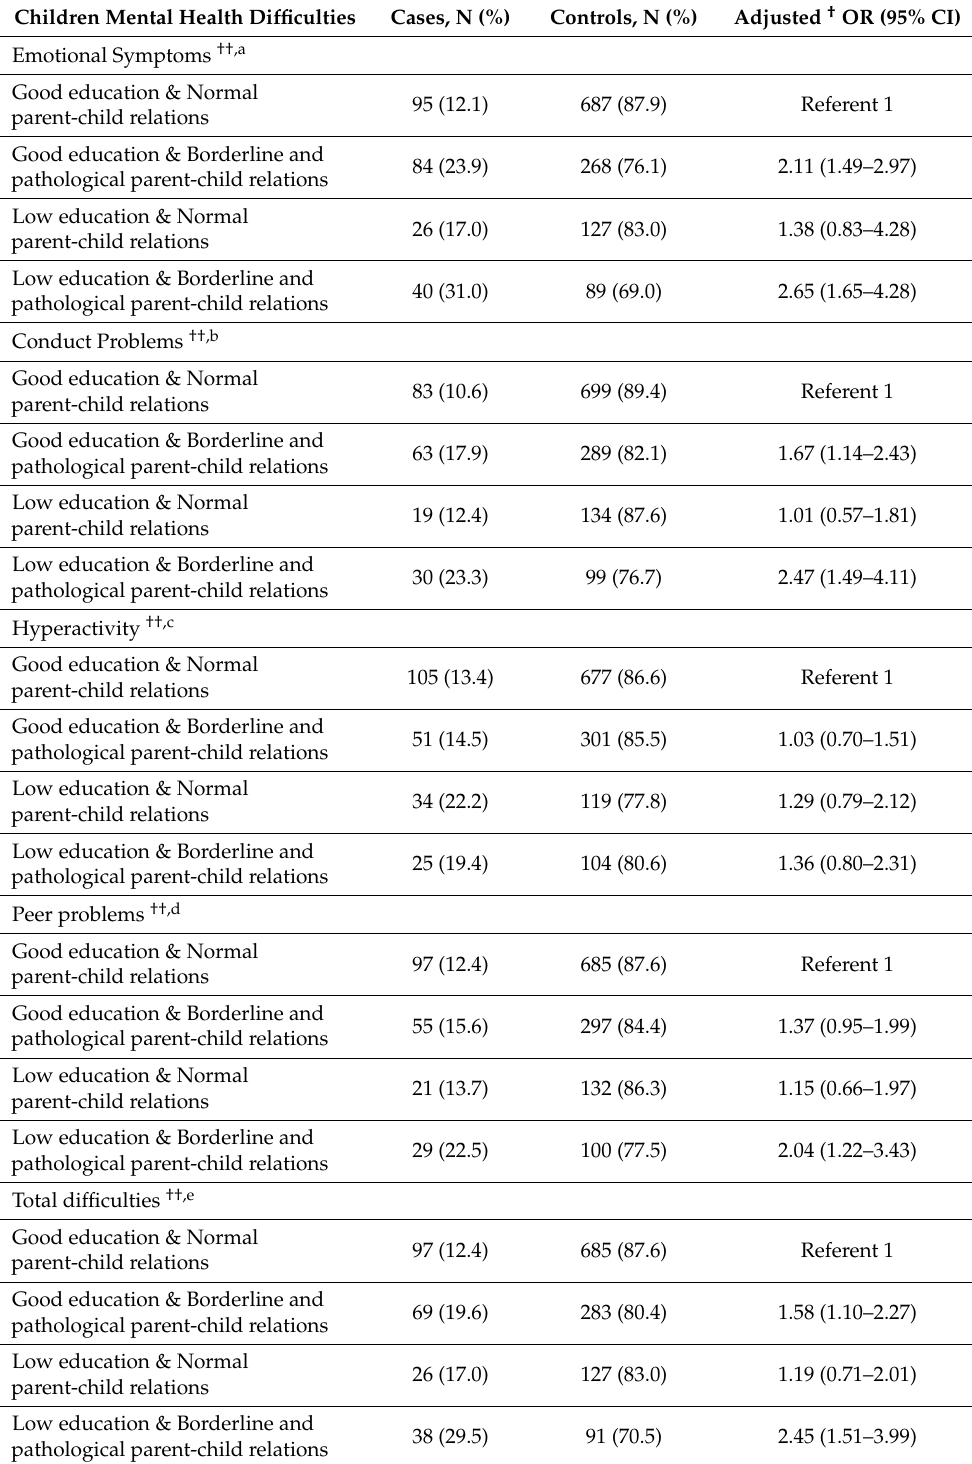
Joint effects of maternal education and dysfunctional relations on children